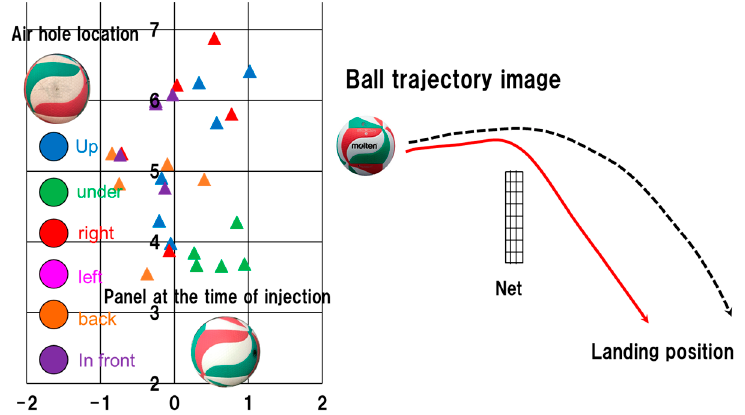
Figure 10. Dependence of air hole position on Flistatec landing